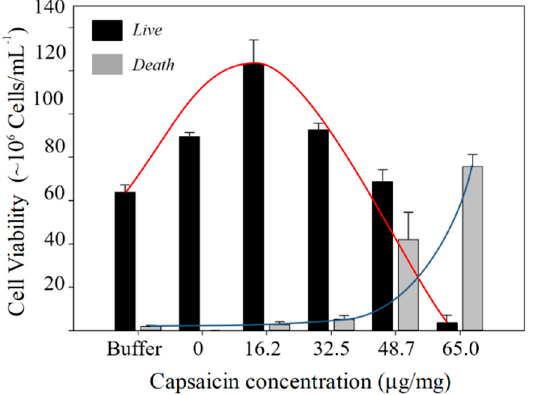
Figure 9. Hormesis response of R. mucilaginosa cells in the presence of BSA-capsaicin nanoparticles administrated directly to the culture. The live cells showed maximal growth at 16.2 µg/mg and growth inhibition at 65.0 µg/mg (the red line shows the positive hormesis behaviour). The death cells showed minimal activity at 0 µg/mg and maximal activity of nanoparticles at 65.0 µg/mg (the blue line shows the negative hormesis